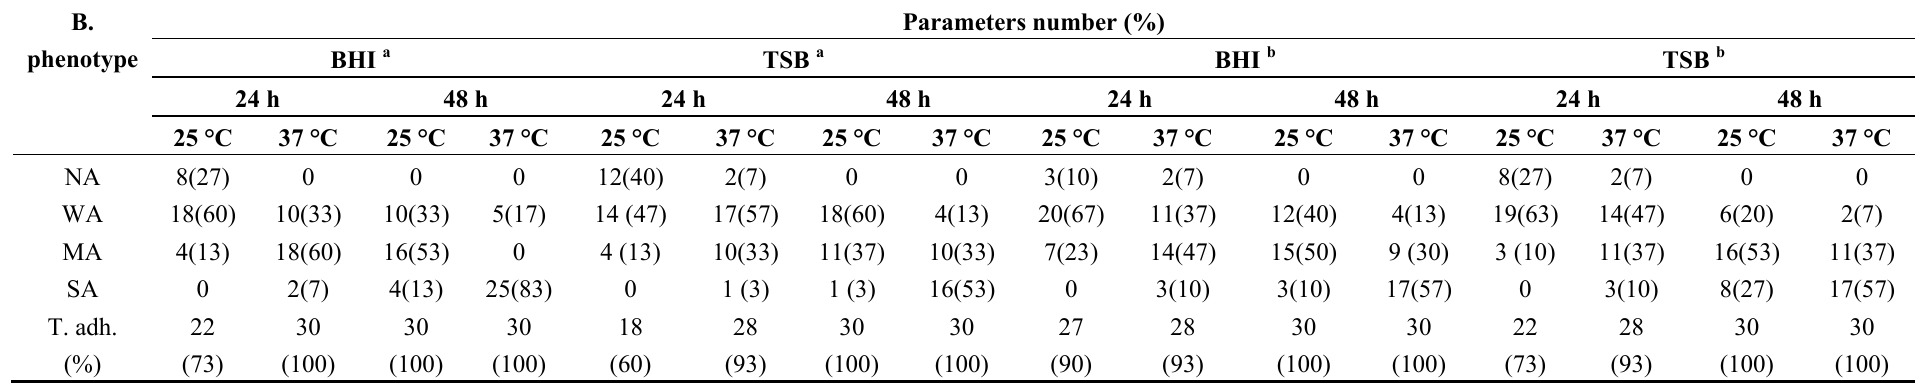
Table 1. The effects of temperature, incubation time and growth medium on the biofilm formation of E. cloacae isolates. B.